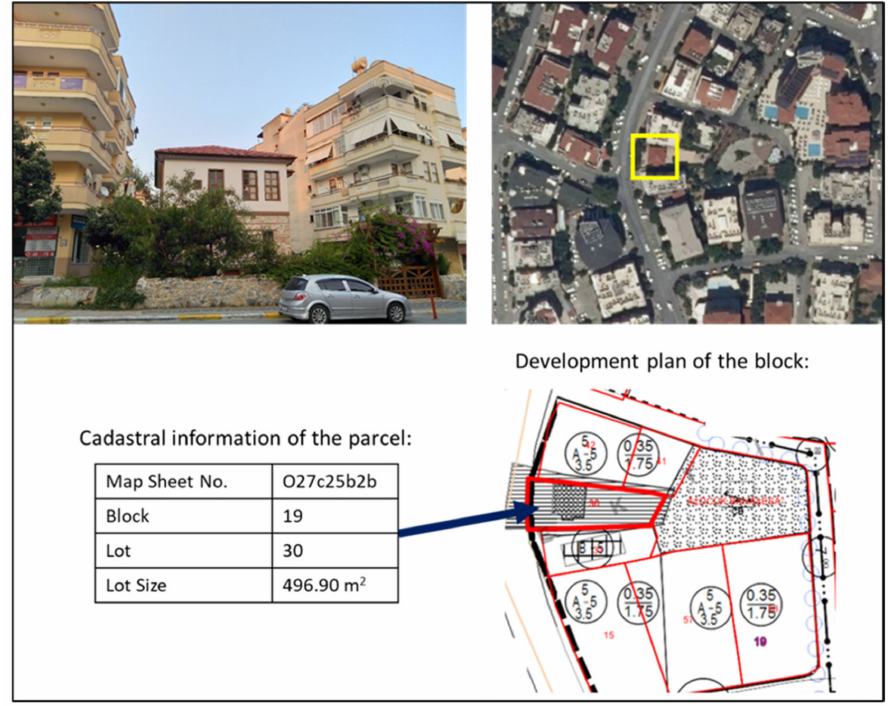
Figure 4. The second example of a historic building. Private residence (photographed in June 2019). This historic building is located on the parcel No. 19/30. The construction rule for the block is maximum five-story and FAR: “1.75”. The size of the restricted lot is 496.90 m 2 and marked by parallel lines in the development plan (Figure 4). The current historic building has approximately 184 m 2 total floor area (determined as explained in the first example above). If it was not restricted, the total development right (total floor area) of the parcel would be 496.90 m 2 × 1.75 ≈ 870 m 2 . Therefore, the landowner is not allowed to use approximately 870 − 184 m 2 = 686 m 2 of floor area on the lot. According to the real estate sales prices in the area, the market value is minimum 5000 TL/m 2 . If we accept this minimum number again, the market value of the restricted floor area of 686 m 2 is worth 686 m 2 × 5000 TL = 3,430,000 TL. The construction cost of the specified floor area would be around 686 m 2 × 1450 TL/m 2 = 994,700 TL. If this number is subtracted from the market value, the total economic loss of the landowner is approximately 3,430,000 TL − 994,700 TL = 2,435,300 TL (~$319,174; USD/TL: 7.63), listed in Table